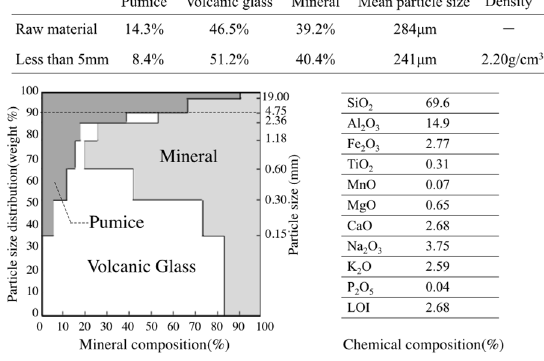
Figure 3. Properties of Ito‐shirasu [12].